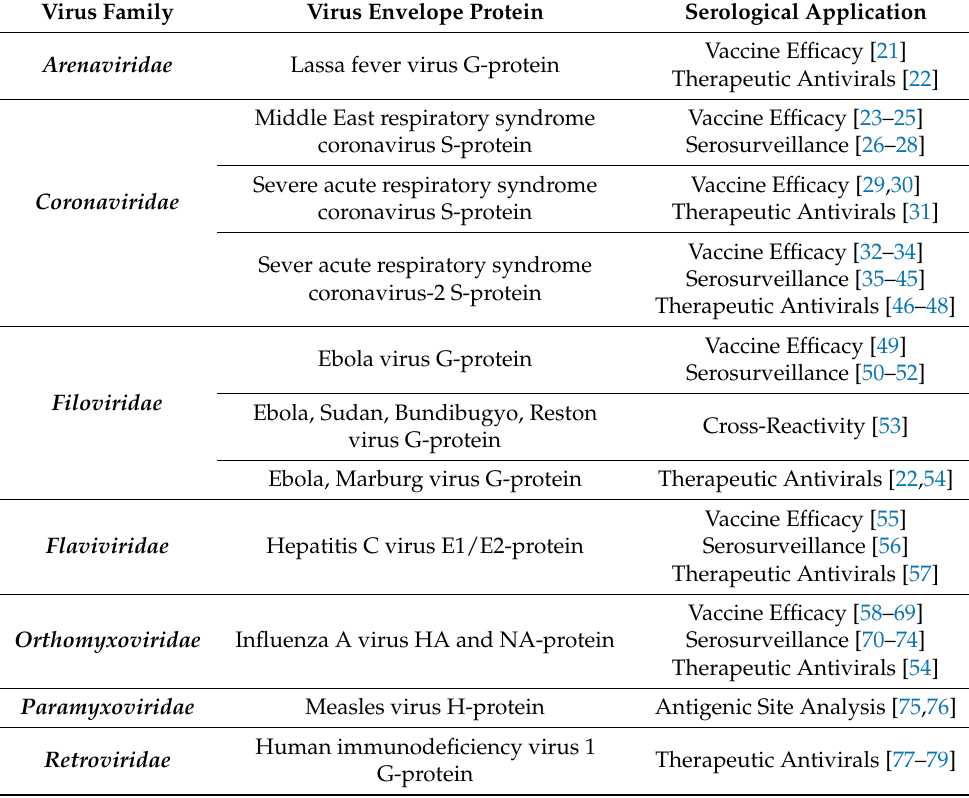
Table 1. Serological applications of pseudotyped lentiviral